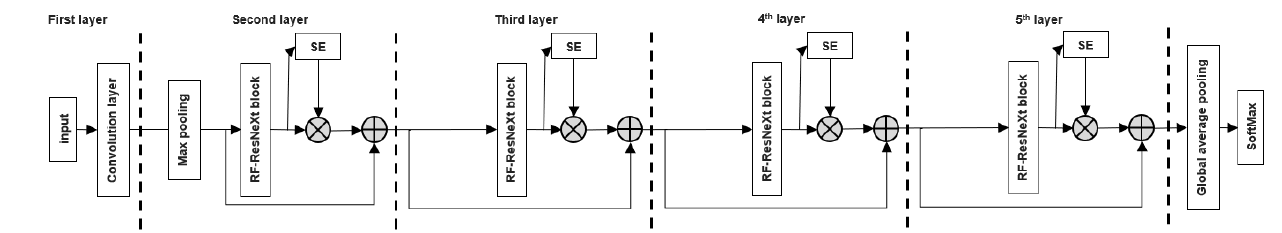
Figure 7. RFSE-ResNeXt network